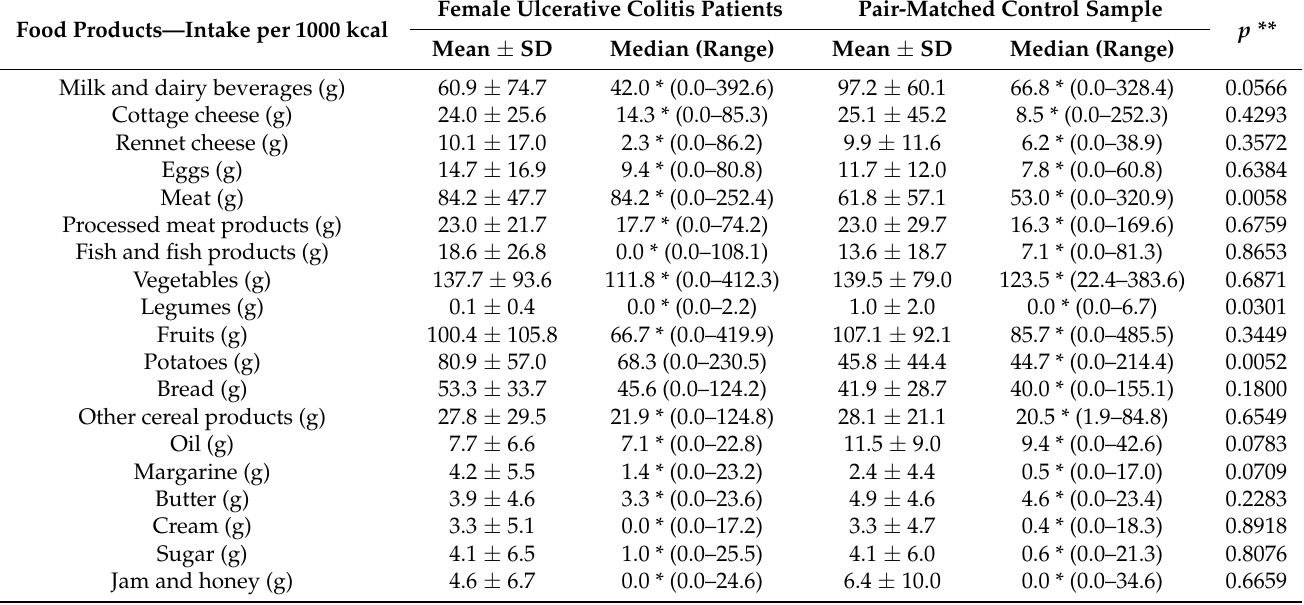
Table 8. The food products intake recalculated per 1000 kcal in the studied Polish female ulcerative colitis individuals, in comparison with a pair-matched control